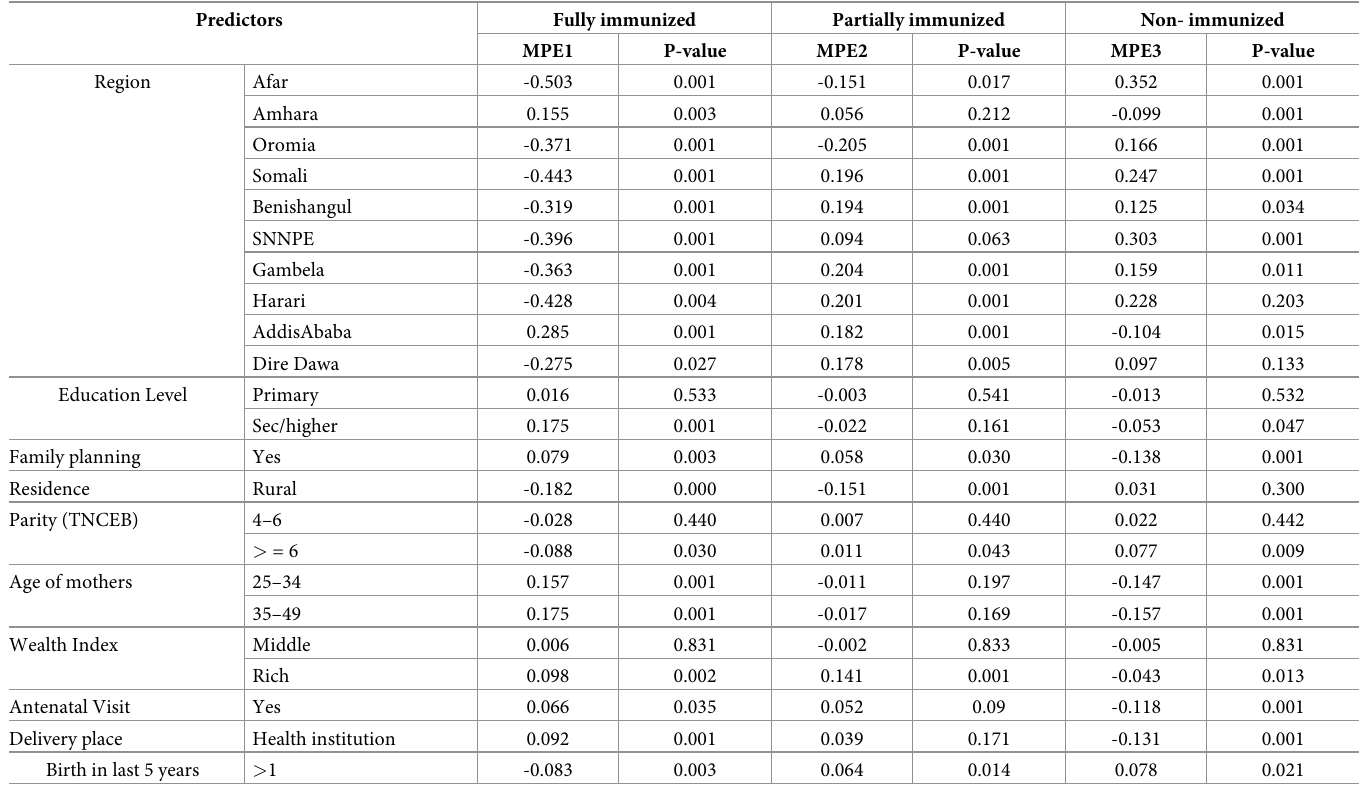
Table 5. Average marginal probability effects (MPE) of predictors on anemia levels, EMDHS 2019 ( n = 1 , 843 ).